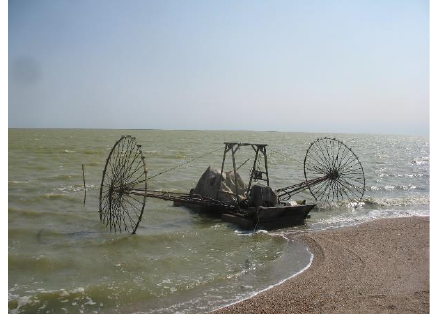
Figure 2. Special boat for harvesting chironomid larvae in the hypersaline lagoon Sivash (Crimea).